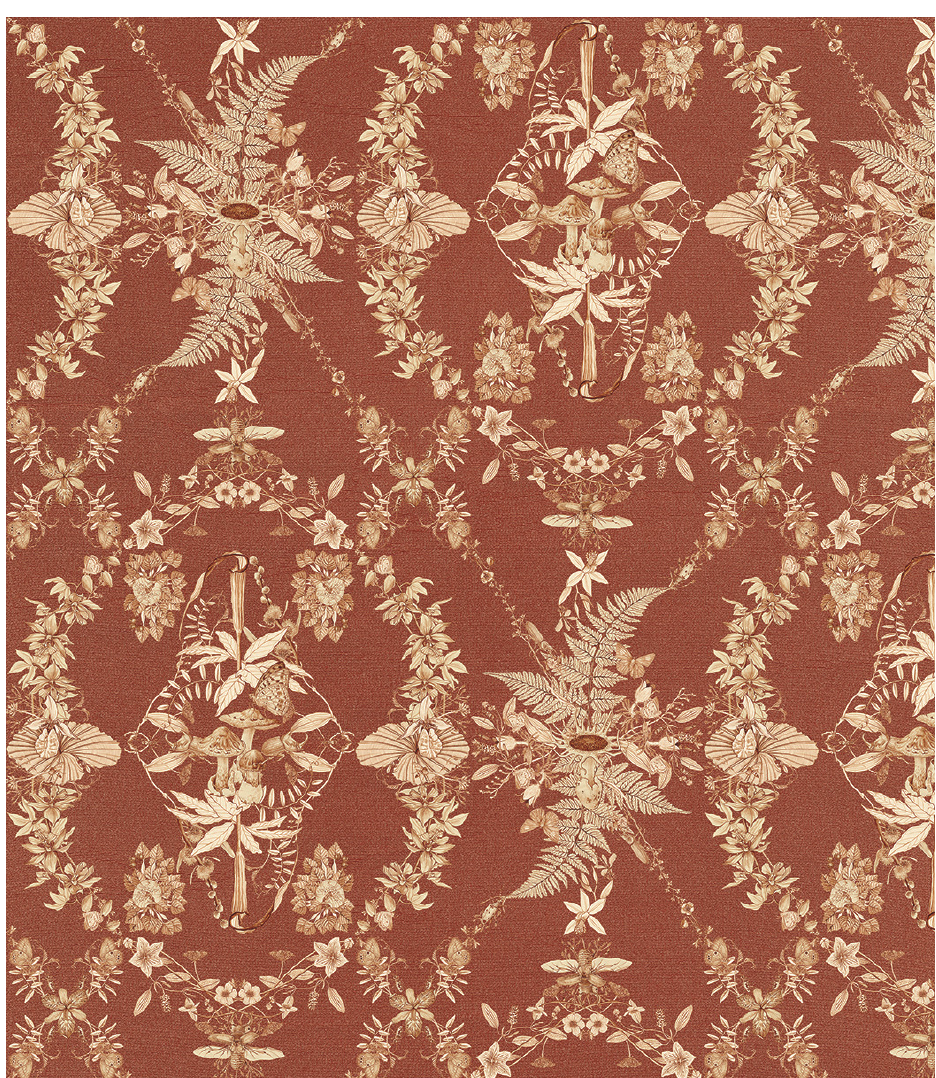
Figure 9. Insect art addressing overharvesting by hunting, as well as habitat destruction and climate change. Asuka Hishiki’s Red list wallpaper KYOTO 2015 (detail of inkjet print, 2021) is a pattern comprised entirely of insects, plants, and fungi, all on the endangered red list in Kyoto prefecture, as of 2015. Included are 12 species of beetles, 3 species of butterflies, a dragonfly, a fly, and a bee, some overhunted because of their beauty. To Hishiki “This piece is a reminder to myself that we can be blind to the devastating problem. Like ‘wallpaper’, it is there in front of us, but we tend to ignore it as vague background decoration.” Image courtesy and copyright of the artist.